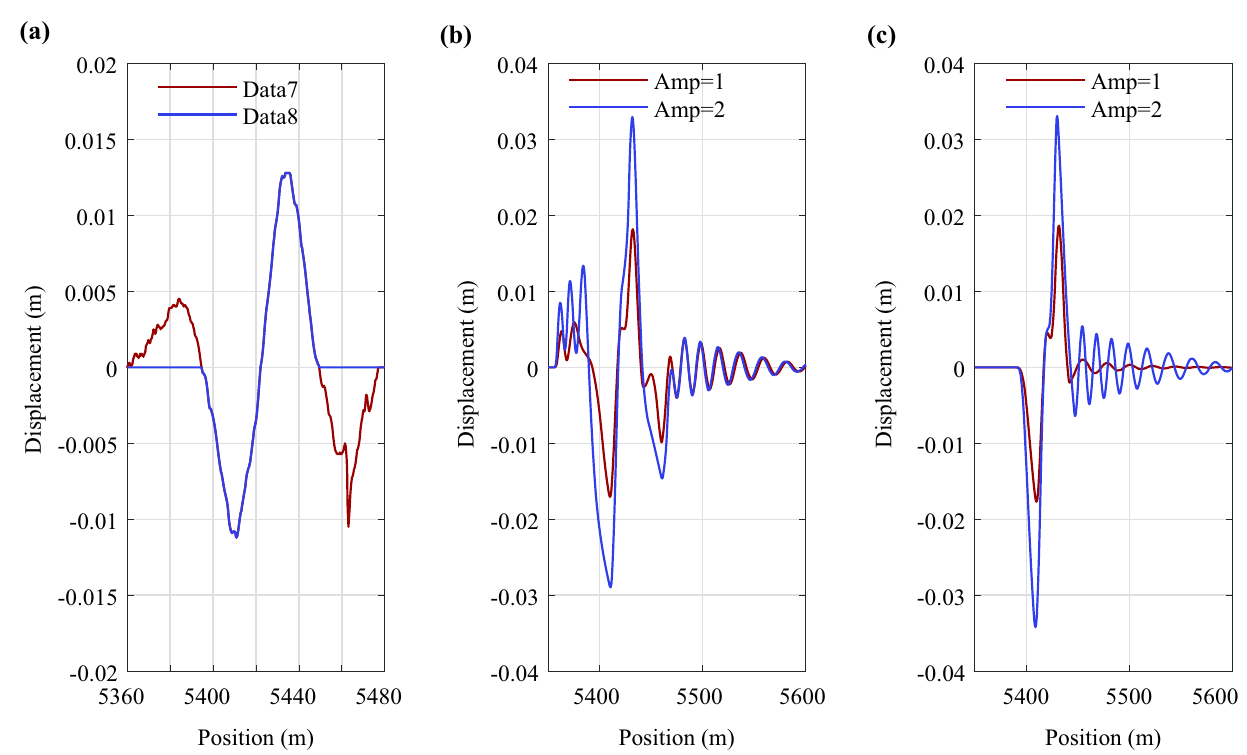
Fig. 16 a Plot of the lateral left rail track displacement of Data7 and Data8. It can be seen that Data7 includes more of the first dip than Data8. b Wheelset displacements resulting from using Data7 as track data in two simulations: one where the track data were multiplied by one (Amp = 1) and one where the track data were multiplied by two (Amp = 2). c The same as b , however, Data8 was used instead of